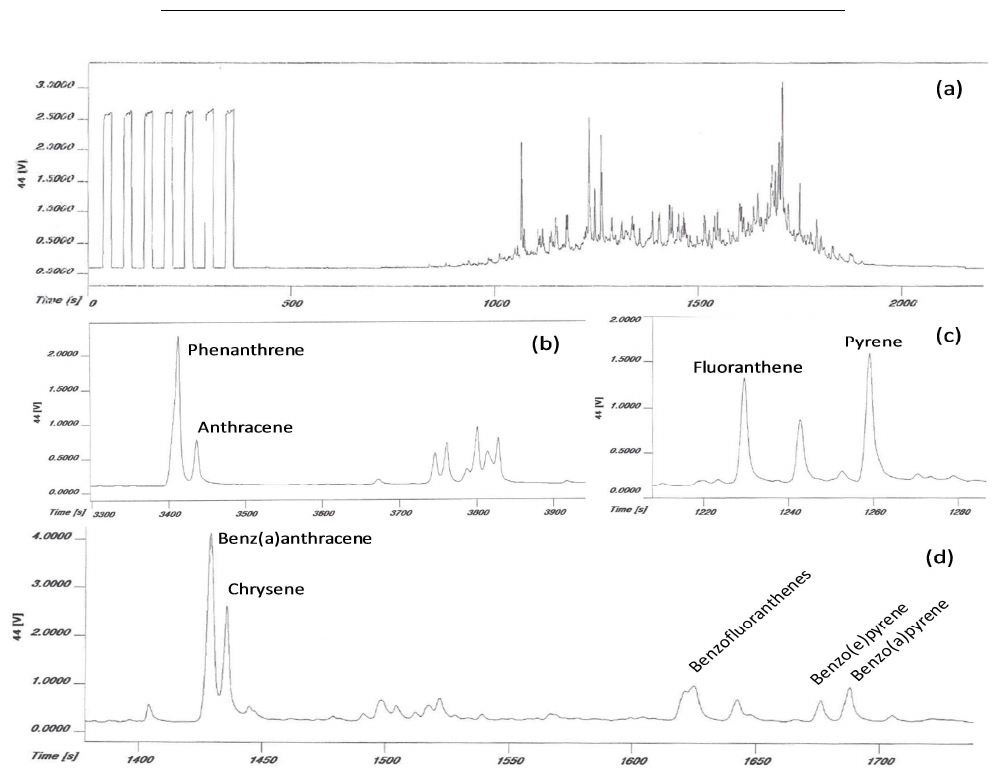
Fig. 1. GC/C/IRMS chromatograms of cork oak prior to HPLC fractionation (a) and after fractionation (b,c,d)